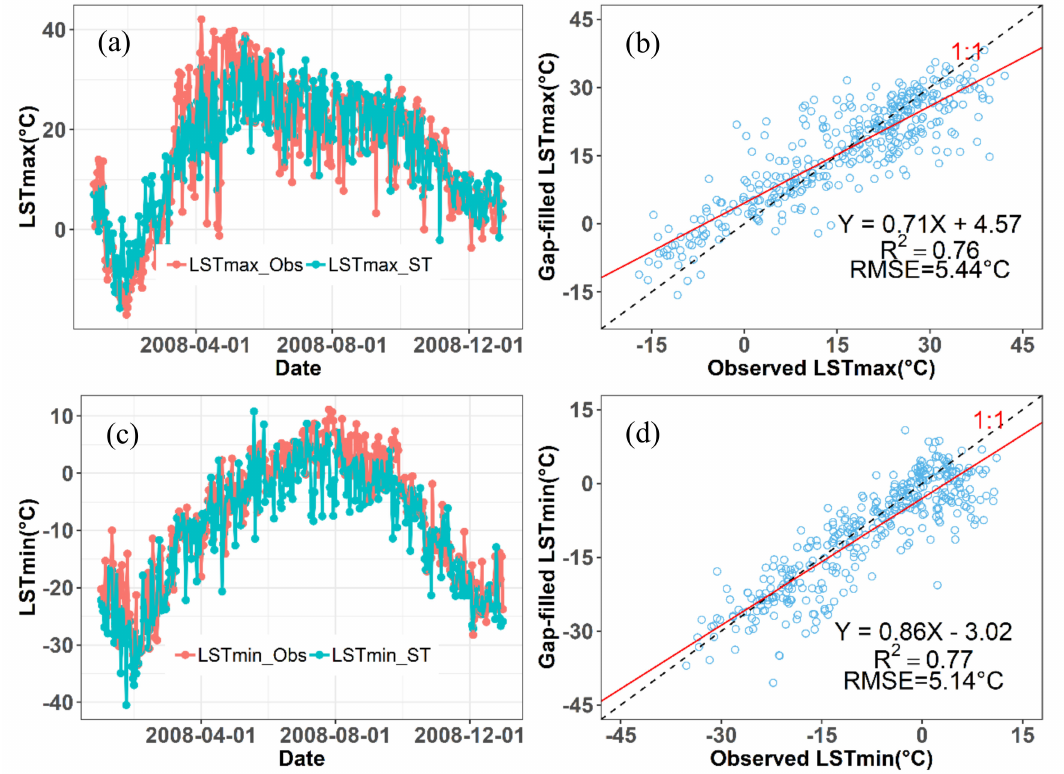
Figure 4. LST maximum and minimum temperature validation with in situ LST measurements in A’rou station. ( a ) and ( b ) show annual daytime comparison at A’rou site. ( c ) and ( d ) show annual nighttime comparison at A’rou